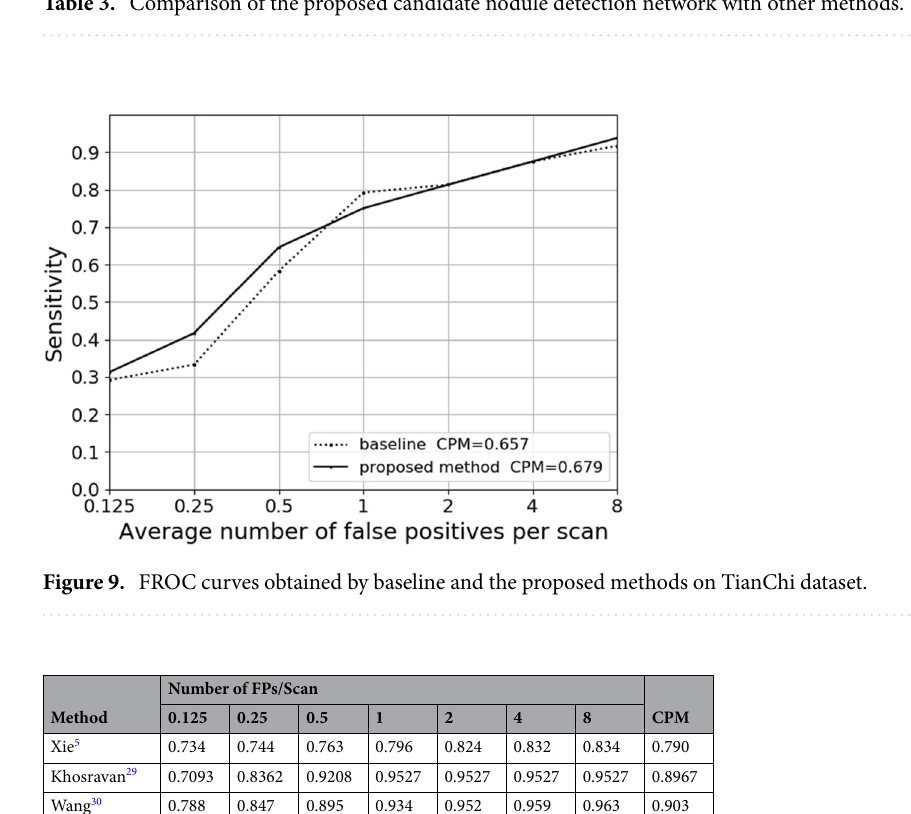
Table 3. Comparison of the proposed candidate nodule detection network with other methods.